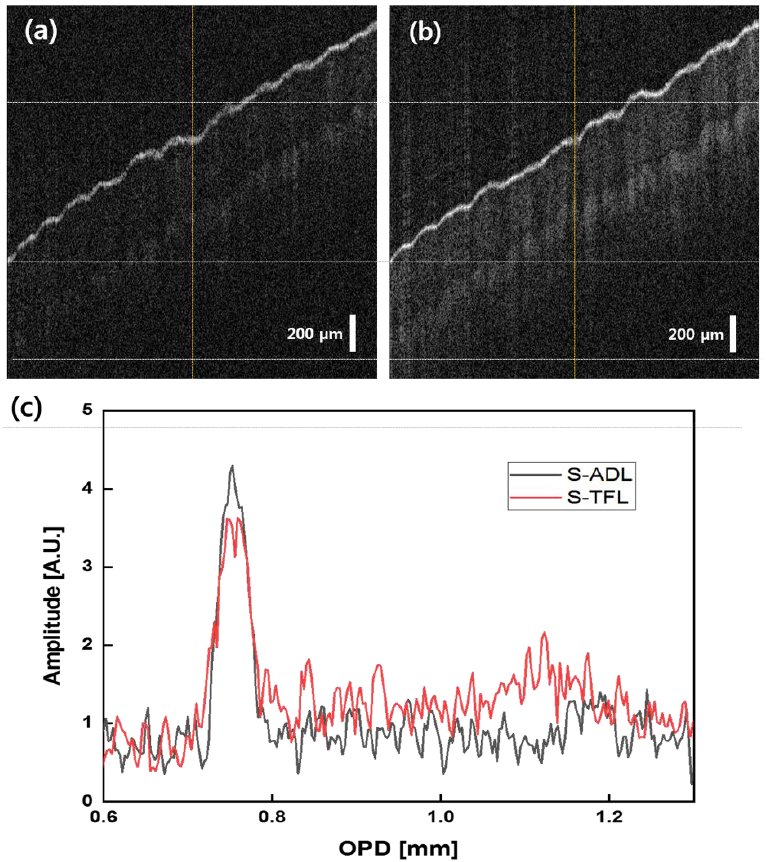
Figure 12. OCT images of the palm of a human hand obtained using ( a ) S-ADL and ( b ) S-TFL. ( c ) Depth profiles at the same A-line of each image.